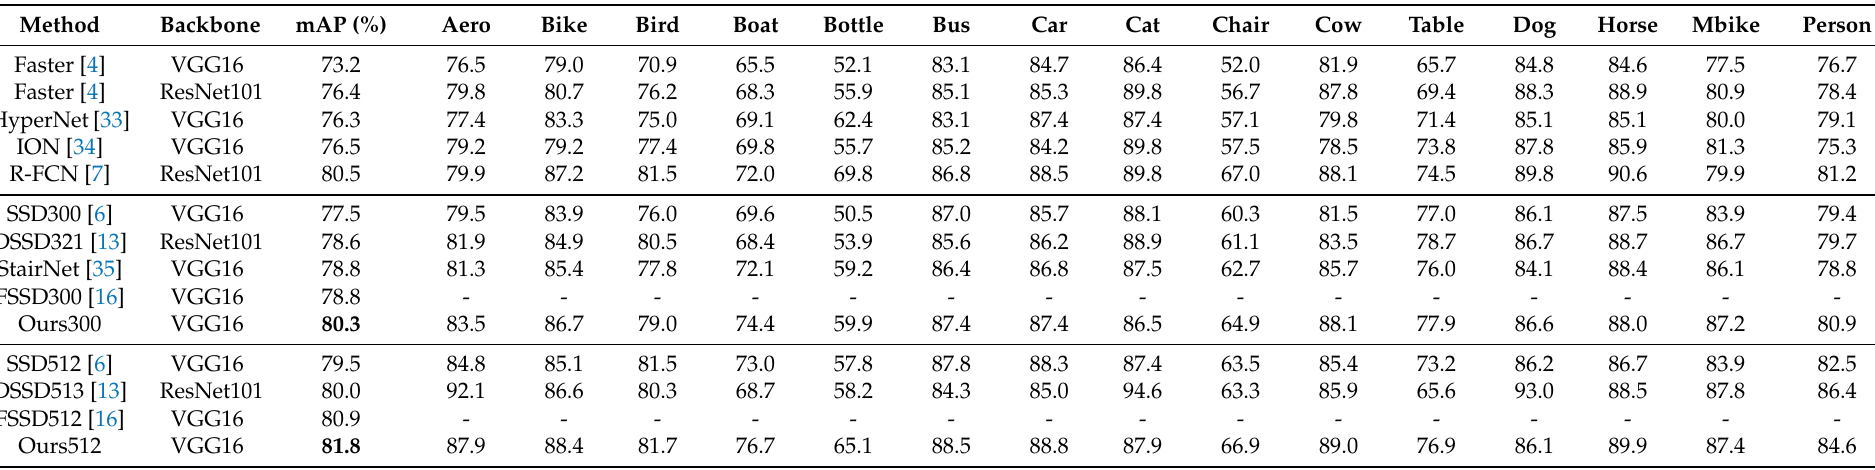
Table 2. PASCAL VOC 2007 test results. Faster R-CNN (Regions with CNN features), HyperNet, Inside-Outside Net (ION) and R-FCN (Regions with Fully Convolutional Networks) adopted inputs with minimum size 600, while StariNet kept with 300 × 300. Data from